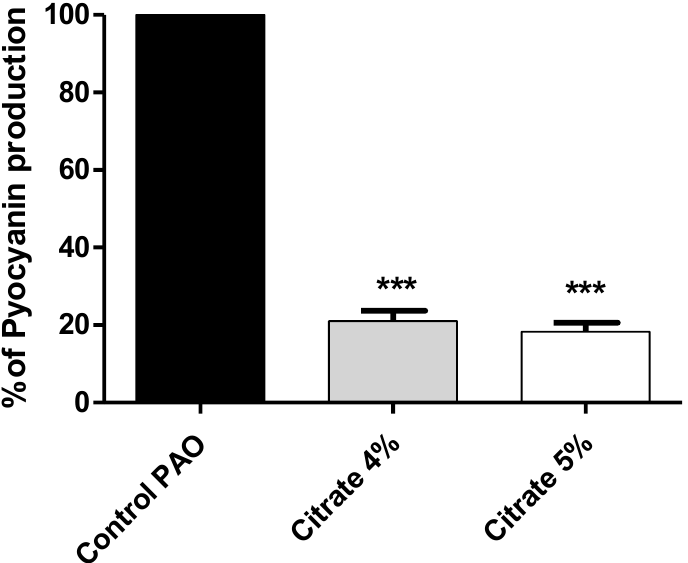
Figure 4. Sodium citrate reduces the production of P. aeruginosa virulent pigment. The absorbances of produced pyocyanin were measured in cultures provided or not with 4% or 5% sodium citrate. Sodium citrate significantly reduced pyocyanin production (*** = p < 0.0001).